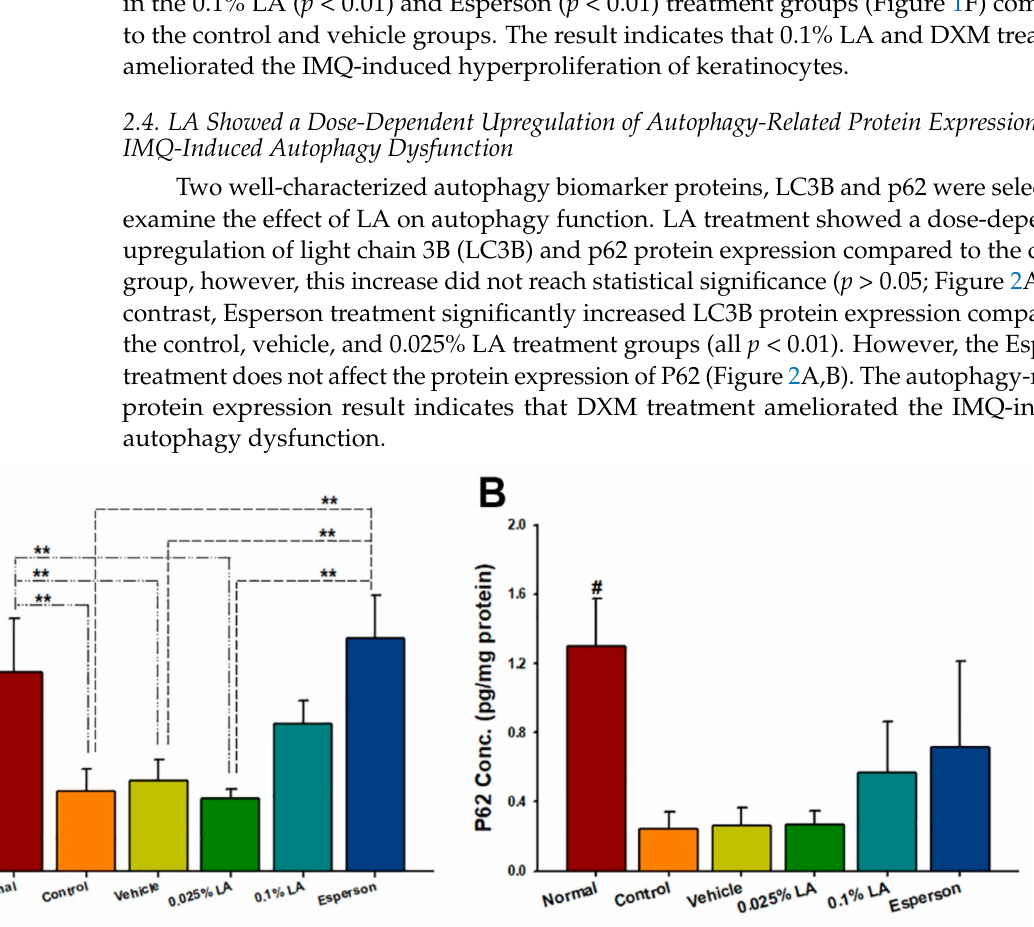
Figure 2. LA showed a dose-dependent upregulation of autophagy-related proteins. ( A ) LC3B ( B ) P62 protein expression. LA, lithospermic acid; # p < 0.01, compared to all the other groups; ** p <